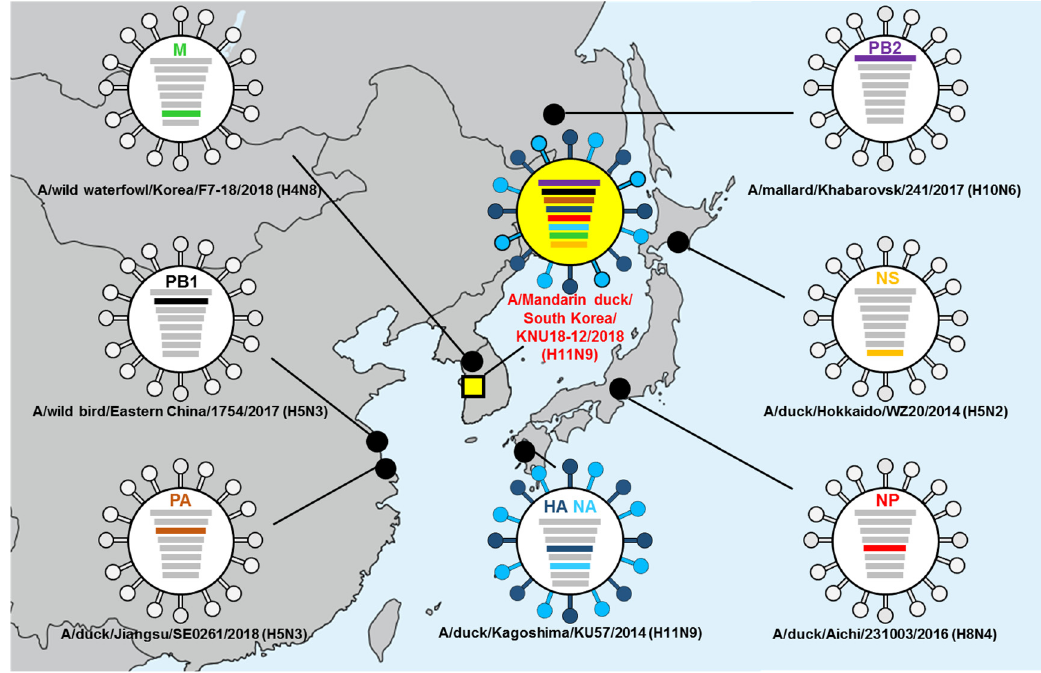
Figure 1. Location of putative origin of genomic compositions of the A/Mandarin duck/South Korea/KNU18-12/2018(H11N9).